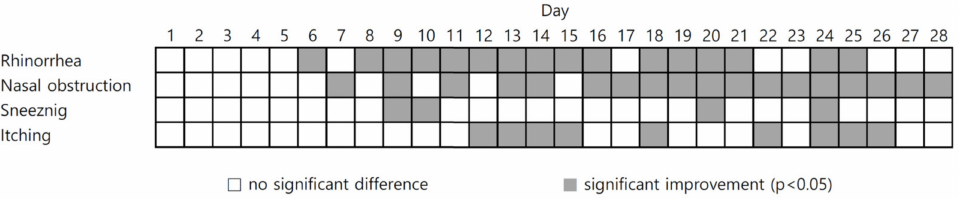
Figure 3. Daily changes in symptoms after phototherapy in patients with allergic rhinitis.